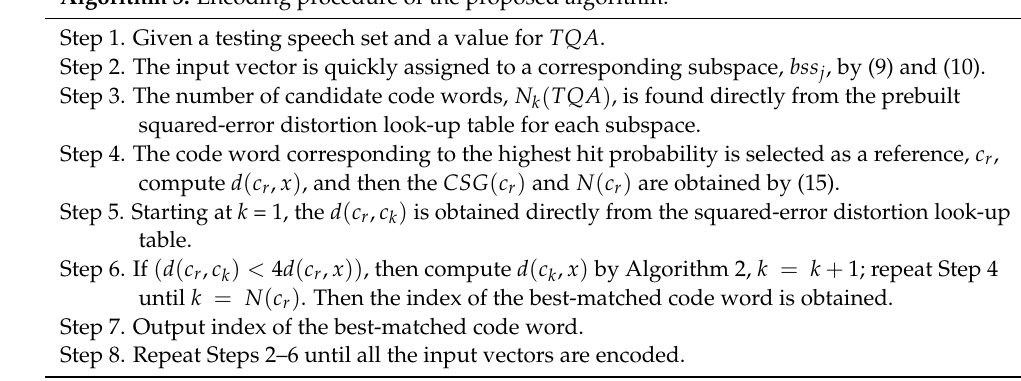
Algorithm 3. Encoding procedure of the proposed